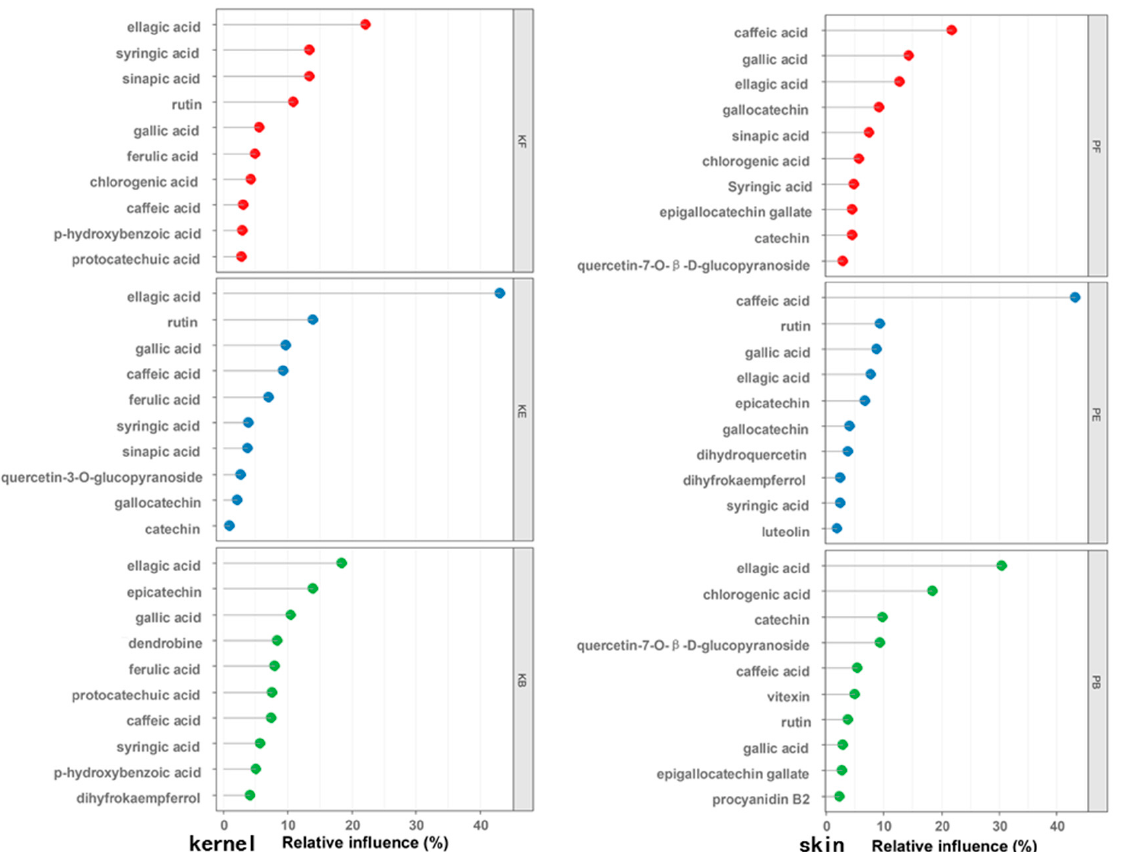
Figure 3. The influence rates of key phenolic compounds to antioxidant capacity in kernel and skin. Note: “KF, KE, KB”, free, esterified and bound phenolics in kernel, respectively. “PF, PE, PB”, free, esterified, and bound phenolics in skin, respectively. The horizontal axis indicates percentages of relative influence; the vertical axis indicates phenolic components.